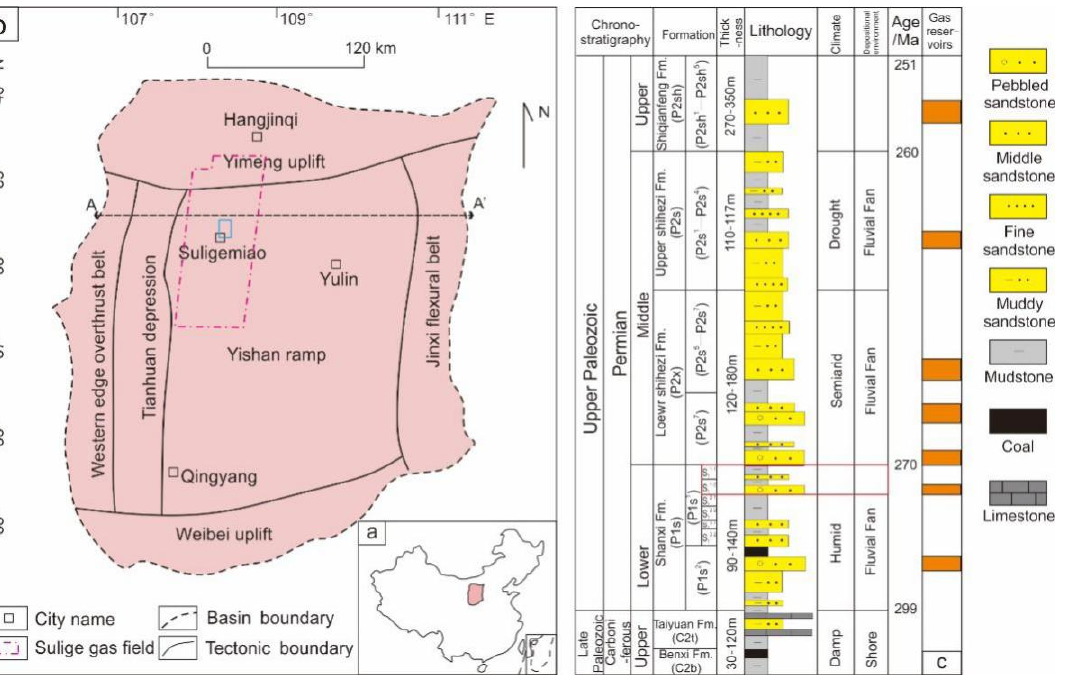
Figure 2. Location of Ordos Basin in China and Tectonic unit division of Ordos Basin ( a , b ) . The red virtual frame in ( b ) indicates the location of Sulige gas field, and the blue box is the research area of this paper, called Su-X block; lithostratigraphy characteristics of Ordos Basin ( c ), the red frame indicates the monolayers of the study.